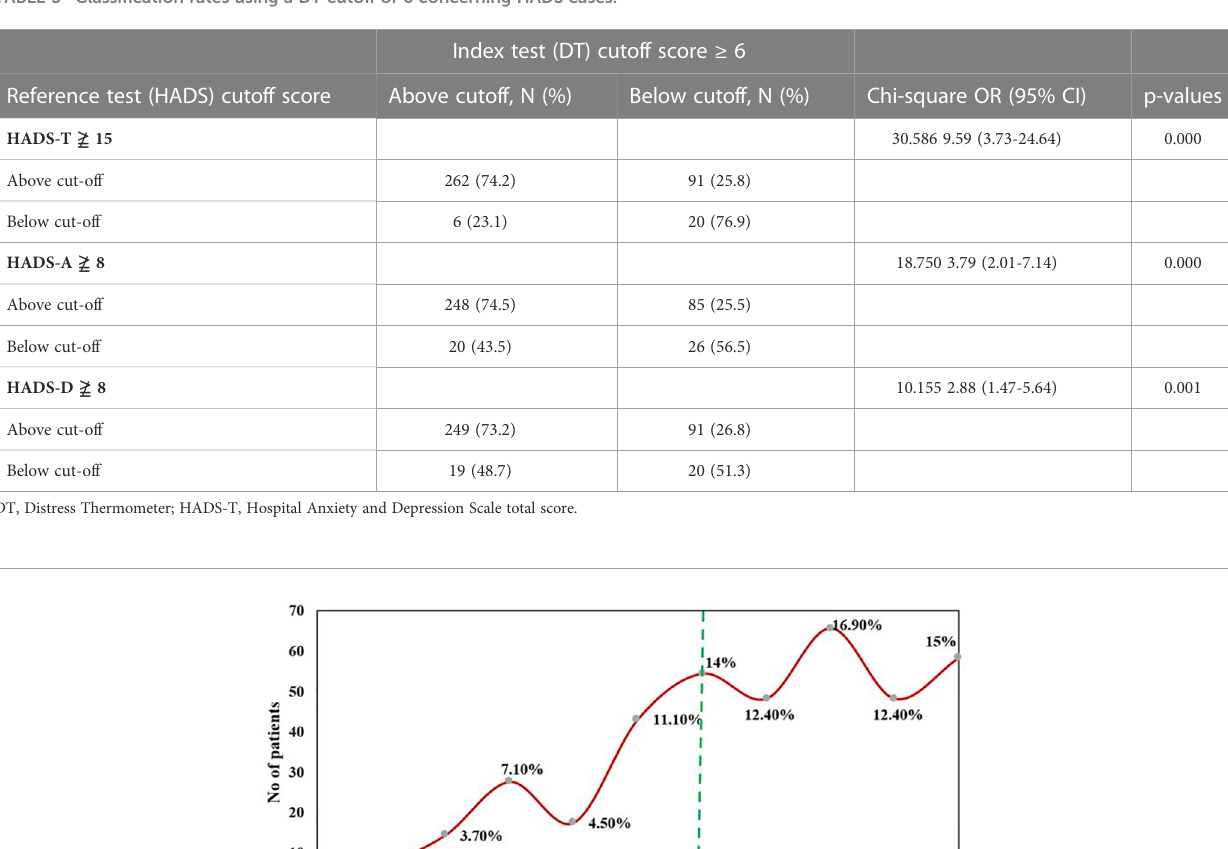
TABLE 3 Classi fi cation rates using a DT cutoff of 6 concerning HADS cases.